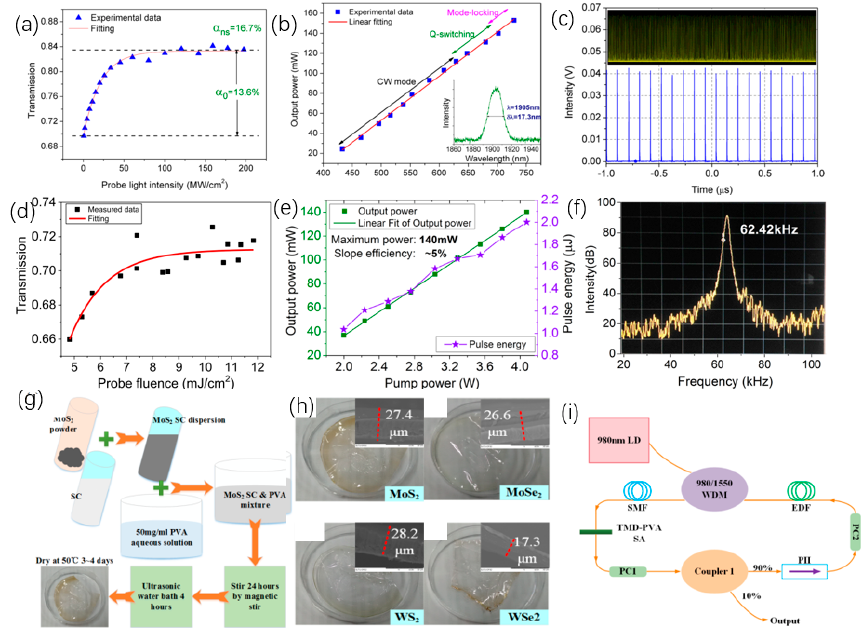
Figure 6. ( a ) Nonlinear absorption curve of MoS 2 on the mirror. ( b ) The change curve of pump power and output power. ( c ) Pulse train diagram of the fiber laser [182]. Copyright2015 IOP Publishing LTD. ( d ) Measurement data of MoS 2 as a saturable absorber. ( e ) Trend chart of output power, pulse power, and pump power. ( f ) Change of radio frequency spectrum with different pump power [213]. Copyright 2019 Institute of Physics Publishing. ( g ) Preparation method of MoS 2 -PVA film. ( h ) Four images of TMDCs–PVA. ( i ) Schematic diagram of the experimental structure with TMDCs–PVA as saturable absorber [214]. Copyright 2015 Optical Society of America.